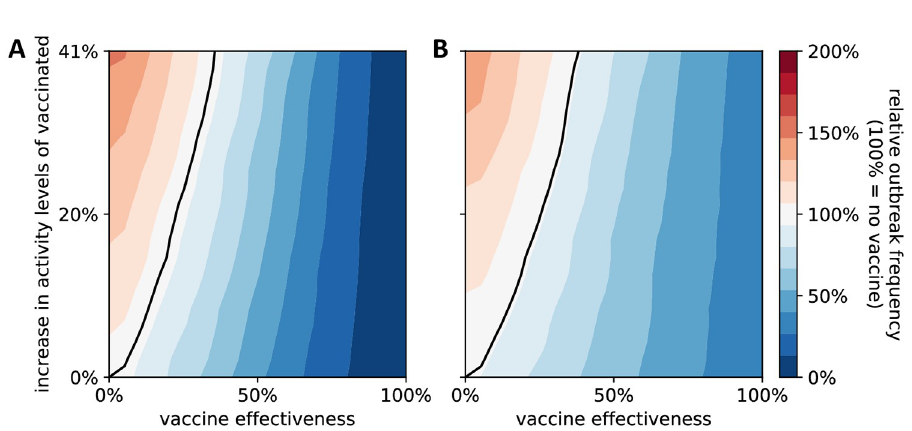
Fig 4. Effect of increased activity levels by individuals who have received a vaccine. The outbreak frequency (relative to the reference case of no vaccine, which is set to 100%) is shown for different levels of vaccine effectiveness (x-axis) and increased average activity levels by those who received a vaccine (y-axis). A black line depicts the x,y- coordinates at which the presence of the vaccine does not change the outbreak frequency. To the left (right) of this line, the presence of the vaccine is detrimental (beneficial). Two different scenarios regarding homophily and correlation of those who vaccinate and those who distance are considered: (A) 0% homophily and no correlation, (B) 50% homophily of those who vaccinate and those who distance and 0.45 correlation. In both plots, a fixed proportion of 65% of all individuals receive a vaccine and 65% of all individuals practice social distancing, i.e., reduce their social contacts by 50%. Data was binned and smoothed using a two-dimensional Savitzky-Golay filter [18] (details in Methods). See S1 Table for a sensitivity analysis where these proportions are varied.